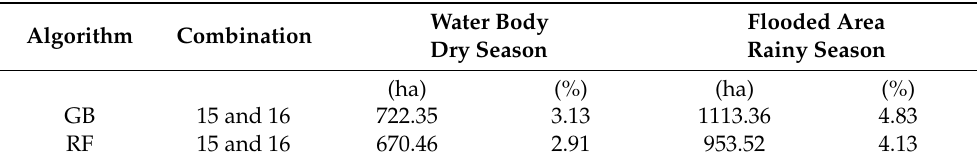
Table 12. Area of water bodies in the dry season and flooding extent in the rainy season calculated by geospatial and temporal analysis of pixels (see Figures 6 and 7).